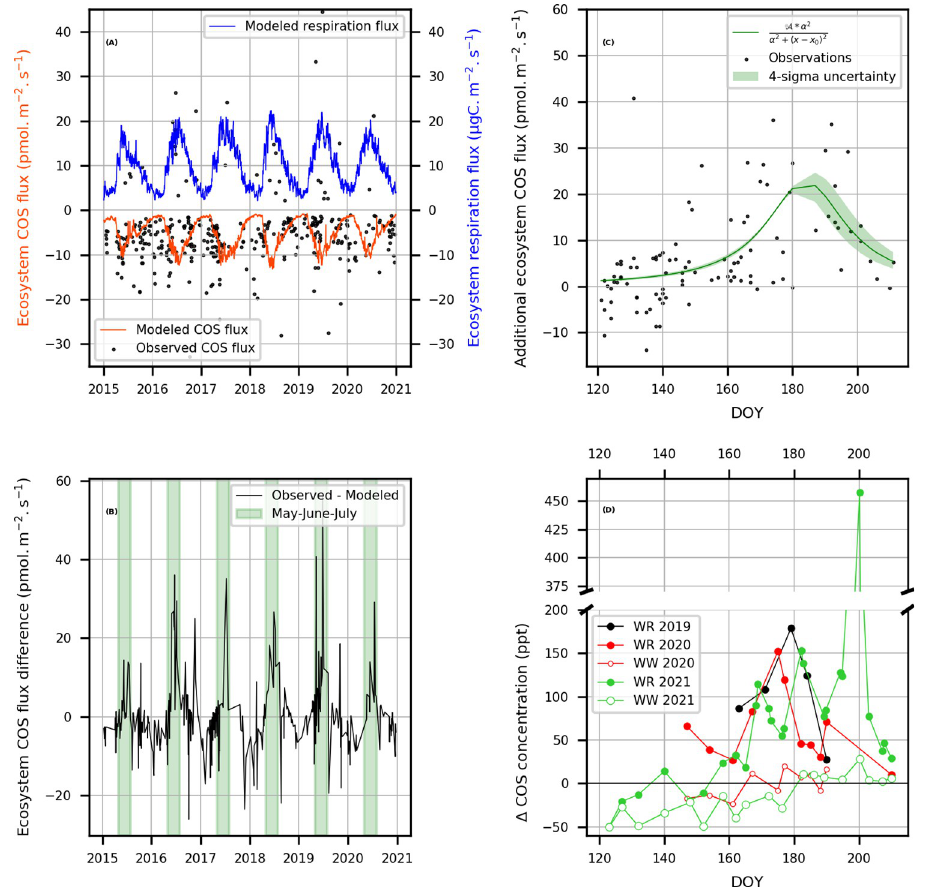
Fig 4. Comparison between observed and simulated nighttime fluxes at the GIF site. (A) Comparison of multi-year variations in simulated nocturnal ecosystem exchange rates of COS (red line) and CO 2 (blue line) with COS fluxes estimated by RTM (black dots, 2014–2020). (B) Difference between “observed” and simulated COS fluxes over 6 years. The period May to July is depicted with a green band. (C) Selected (May to July) data gathered from panel (B) then fitted with a polynomial function of the type depicted in this panel which estimates the dynamics of an additional, yet unidentified, source of COS. Fit: x0 = 63.1 ± 0.6, A = 22.7 ± 0.6, alpha = 15.3 ± 0.4, R 2 = 0.33. The light green shading corresponds to 4-sigma uncertainty. (D) Comparison of the dynamics of COS exchange between crops (WR: winter rapeseed; WW: winter wheat) and the atmosphere, assessed indirectly from horizontal concentration gradients ( Δ COS) downwind and upwind of selected plots (Fig 1). The full record including data collected between late March and late April are displayed in S6 Fig. In 2021, the survey of crops was interrupted before harvest, whereas in 2020, the last sample was collected after harvest. Rapeseed growth stages–year 2021: day of year (DOY) > 110–140, flowering; > 140–160, development of fruit; > 160–190, ripening; > 190–210,